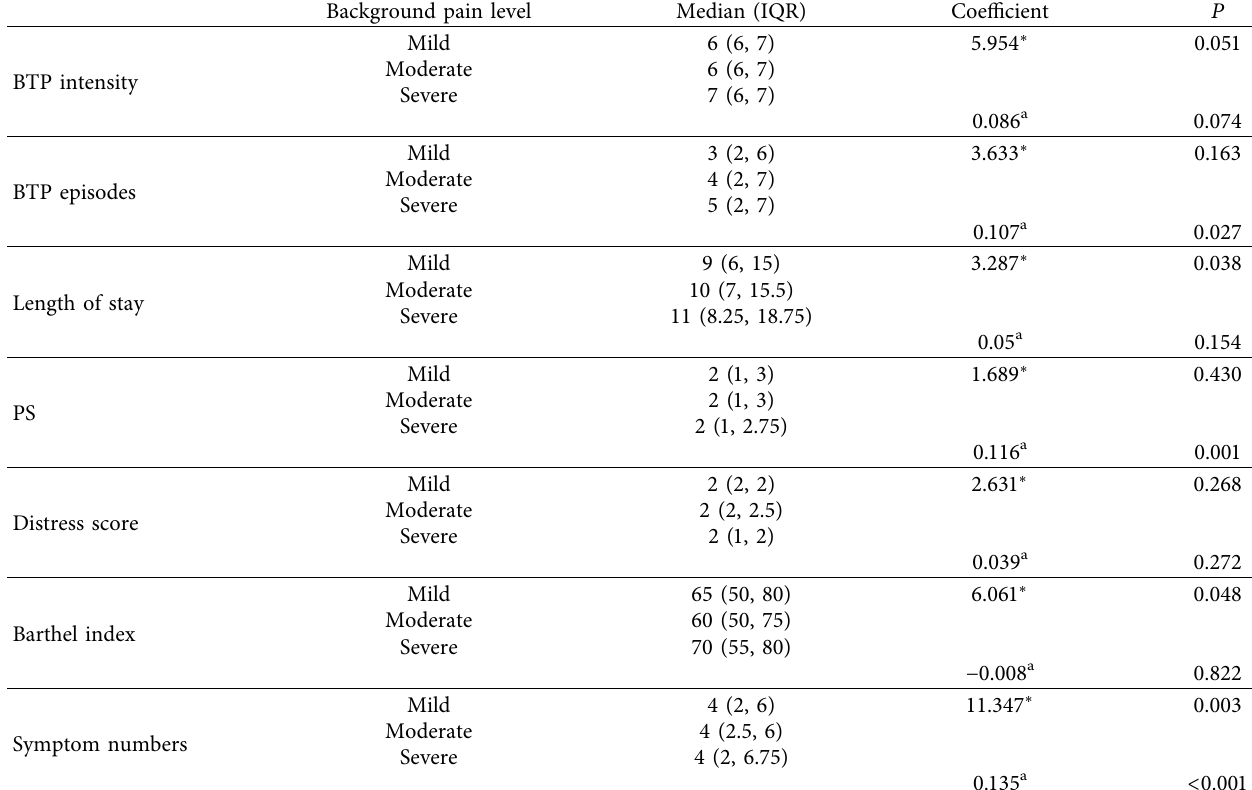
Table 2: Comparison and correlation analysis in patients with different background pain